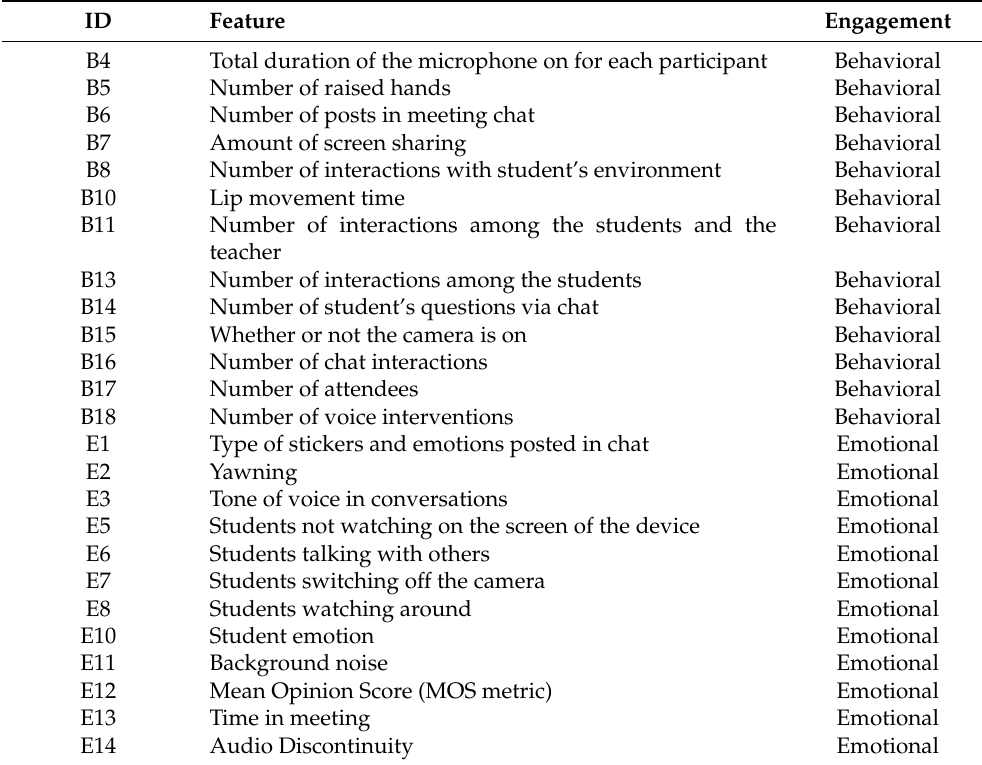
Table 5. Resulting set of features obtained at the Feature Identification